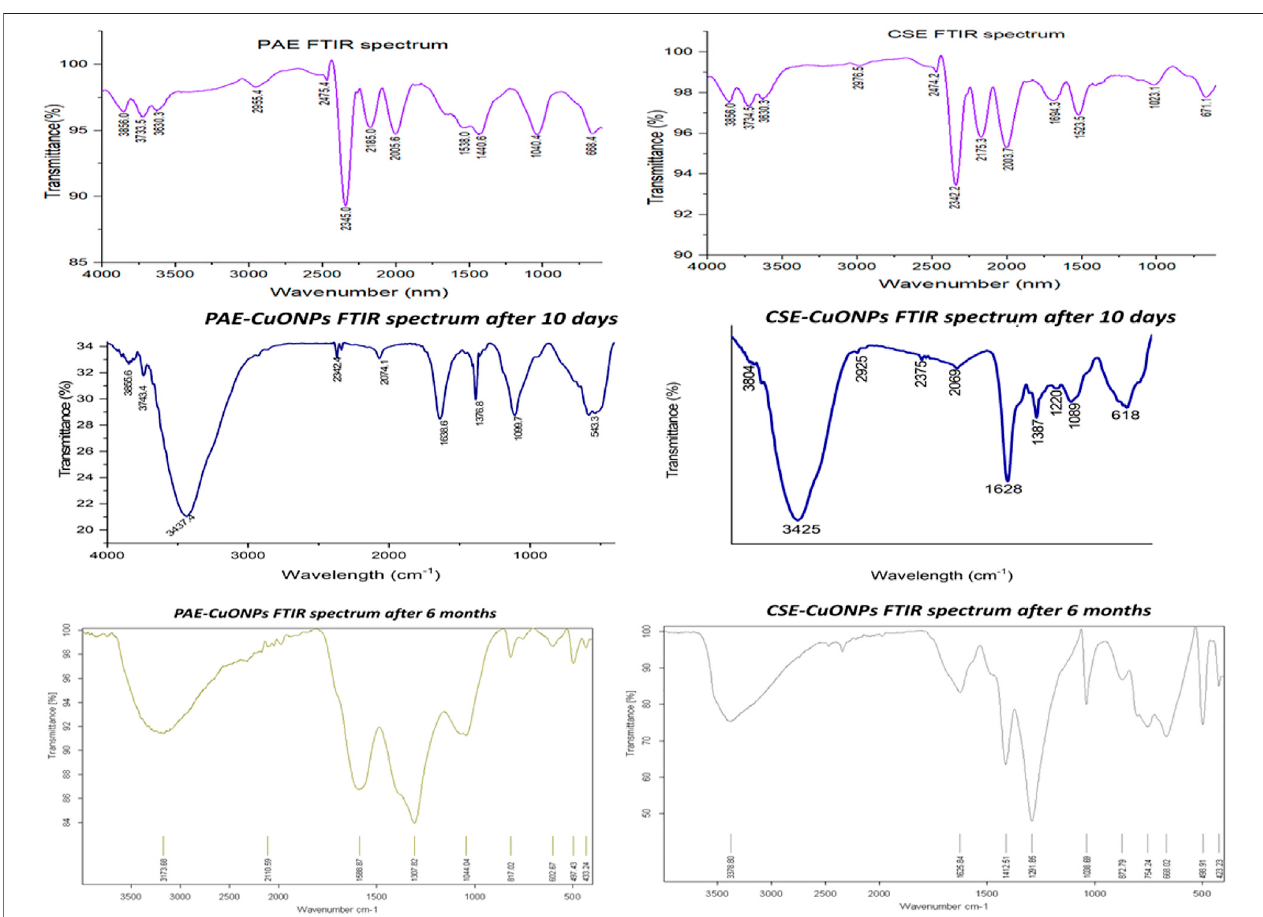
FIGURE 3 | FTIR absorbance spectra for PAE, CSE, PAE-CuONPs, and CSE-CuONPs. PAE stands for Prunus africana extract, CSE; Camellia sinensis extract, PAE-CuONPs; Prunus africana biosynthesized copper oxide nanoparticles and CSE-CuONPs; Camellia sinensis green synthesized copper oxide nanoparticles.